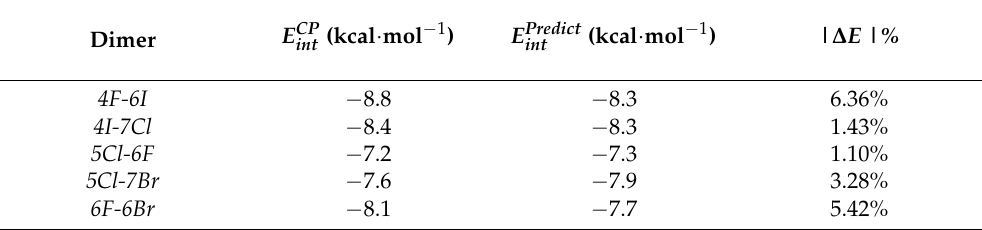
) are computed at the M06/aug-cc-PVTZ(- Table 2. Counterpoise-corrected interaction energies ( E CP int ) of the selected PP)//M06/cc-PVTZ(-PP) level of theory and predicted interaction energies ( E Predict int dimers. The absolute percentage error of each prediction ( | ∆ E | % ) is provided as well. − 1 ) Dimer E CP int (kcal · mol